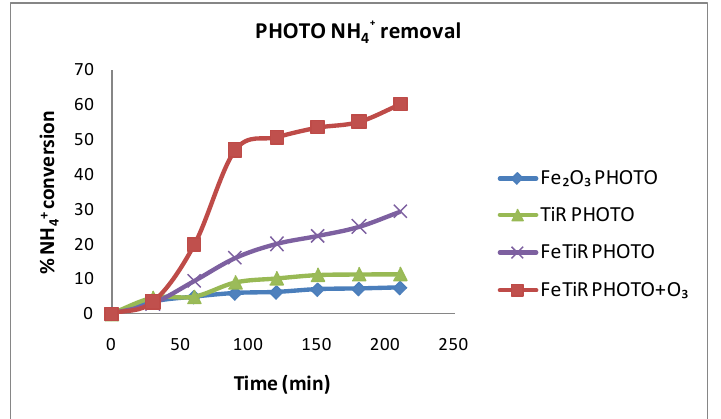
Figure 14. Comparative NH 4+ photodegradation for the investigated samples.